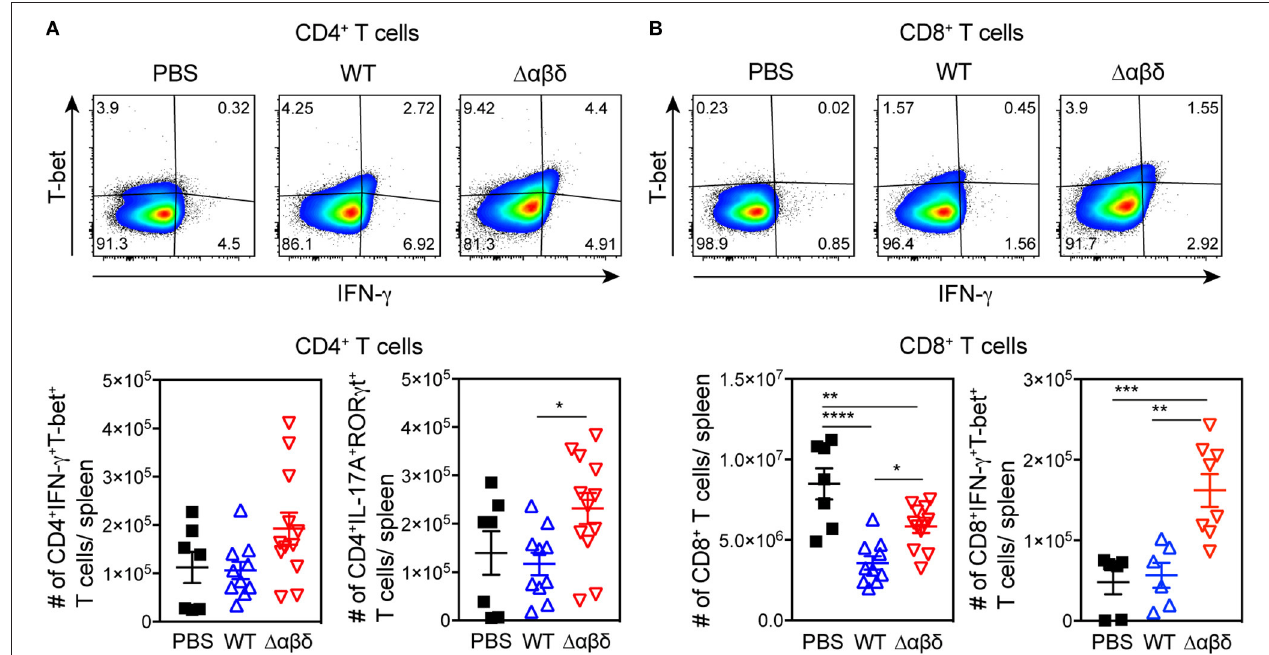
FIGURE 6 | PSM-dependent inhibition of Th1 and Th17 polarization. C57BL/6J WT mice were either treated with PBS or infected with S. aureus USA300 WT or the PSM-deficient S. aureus USA300 1 αβδ mutant strain for 3 days and splenocytes were analyzed for CD4 + T cells by flow cytometry. (A) Pseudocolor plots show the frequency of IFN- γ + T-bet + cells among CD4 + T cells in the spleen of PBS-treated or infected mice with the corresponding graphical summary of CD4 + IFN- γ + T-bet + and CD4 + IL-17A + ROR γ t + T cell numbers. (B) Pseudocolor plots show the frequency of IFN- γ + T-bet + cells among CD8 + T cells with the corresponding graphical summary of CD8 + and CD8 + IFN- γ + T-bet + T cell numbers. Every symbol represents one mouse. The graphs represent the mean ± SEM with data pooled from multiple experiments; quantity of mice and experiments per condition and time is depicted in Table S2 (one-way ANOVA followed by Tukey’s post-hoc test; * p < 0.05, ** p < 0.01, *** p < 0.001, **** p <